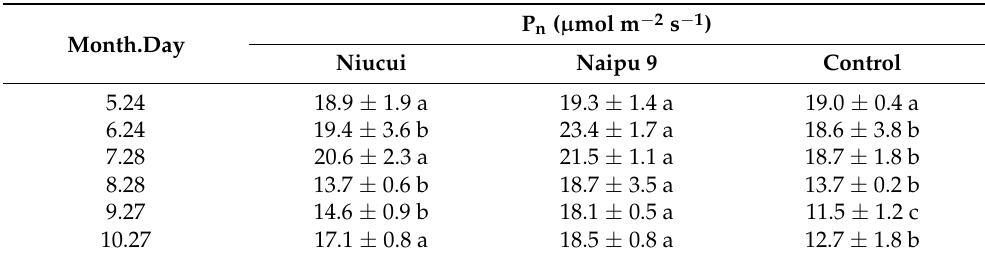
Table 6. Effects of spraying calcium fertilizer on net photosynthetic rate (P n ) of apple leaves.